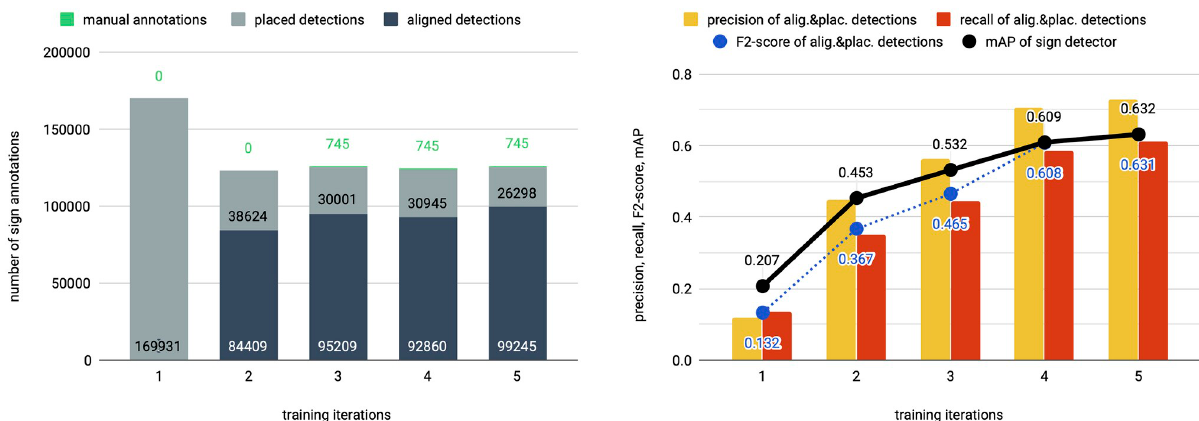
Fig 5. Effect of iterative training on ratio of generated detection types and detection performance. The first two iterations (1–2) are weakly supervised (w/o manual annotations) followed by three semi-supervised iterations (3–5) which include fine-tuning on 745 manual sign annotations. (a) The ratio of detection types varies between iterations. The training starts with only placed detections which are replaced with an increasing number of aligned detections over the course of training. (b) The precision and recall of the generated sign annotations and the performance (mAP) of the sign detector on the test set. To improve the sign detector, the quality and quantity of generated sign annotations needs to increase over the course of training.